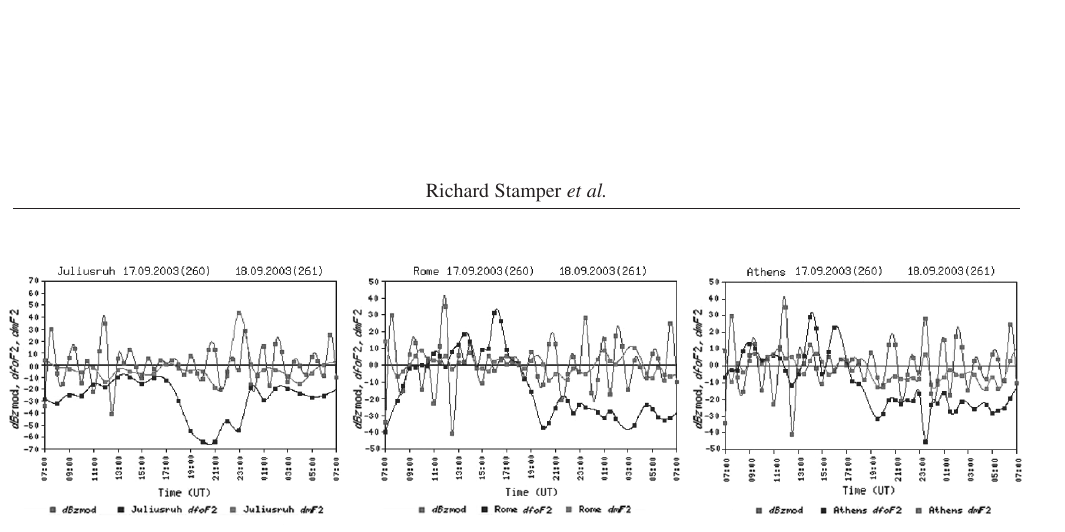
Fig. 3.3. IMF- Bz rate of change from the ACE spacecraft, with dfoF 2 (%) and dmF 2 (%) for the ionosonde sta- tions at Juliusruh, Rome and Athens during the 24 h from 07:00 UT on 17.09.2003 to 07:00 UT on 18.09.2003.